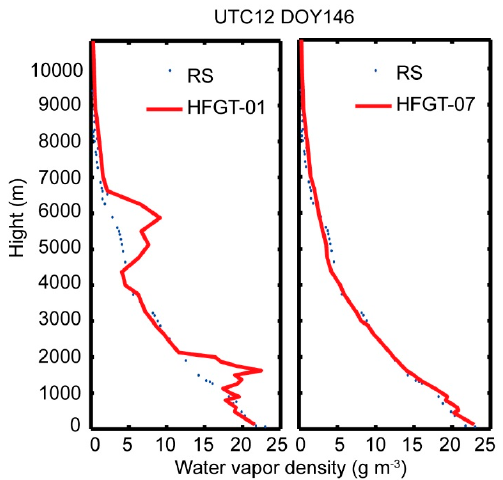
Figure 13. Water vapor profiles (red curves) obtained from HFGT-01 and HFGT-07 were compared against that of RS (blue points) on DOY 146.